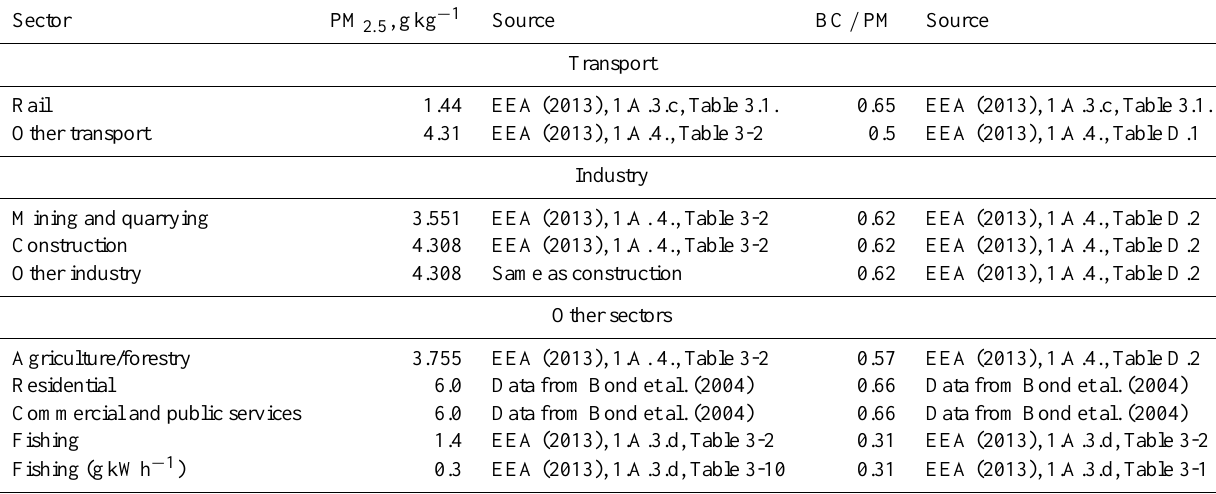
Table 1. PM 2 . 5 emission factors and BC / PM ratios for diesel sources.